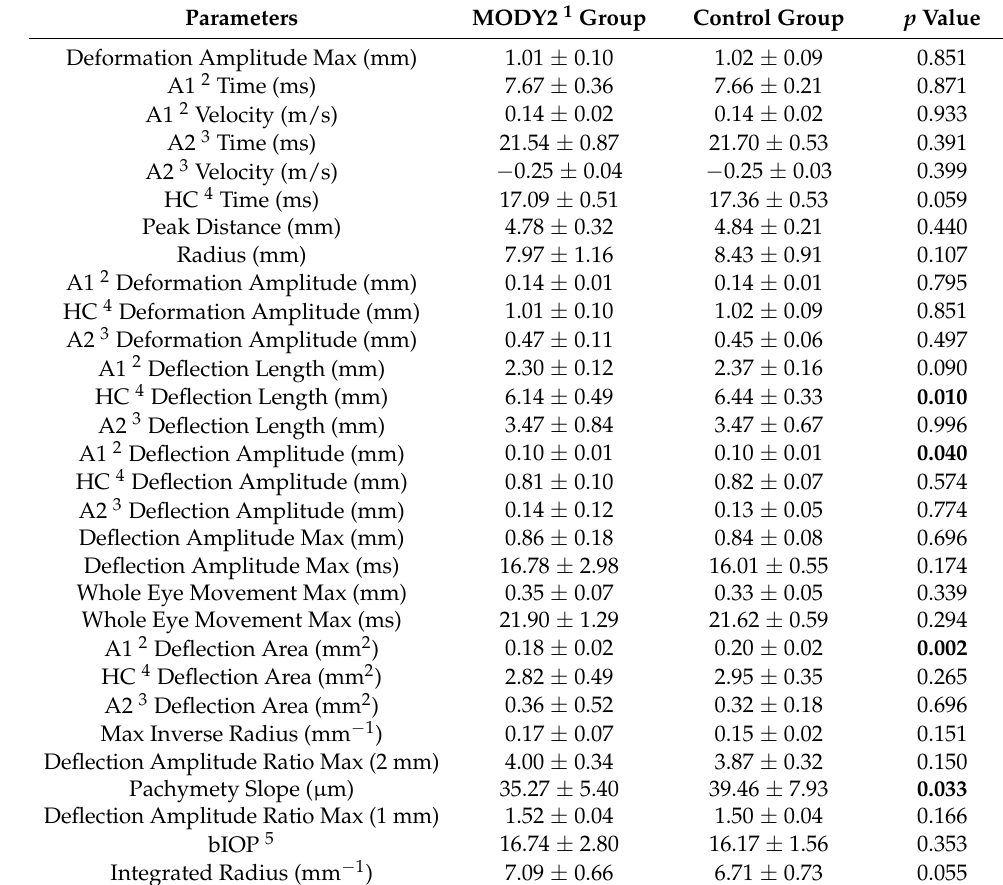
Table 4. Comparison of biomechanical features provided by Corvis ST in MODY2 patients and in healthy